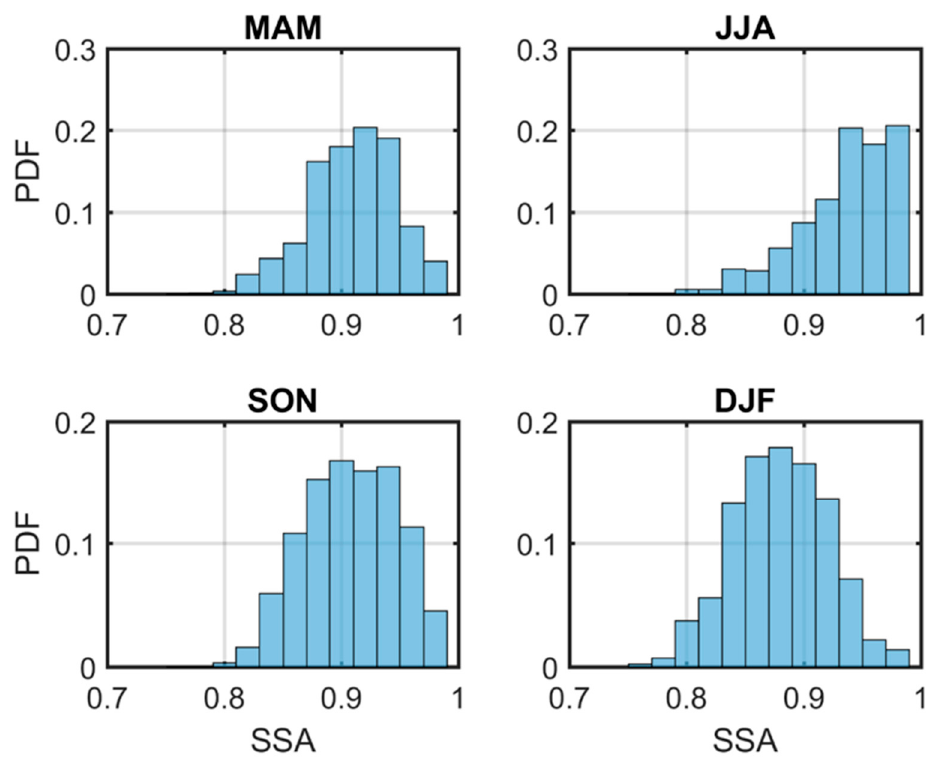
Figure 15. Histograms of the SSA(single scattering albedo) values at the Beijing-PKU site during 2016–2019. Table 1. Statistics of the retrieved AOD 550 nm against ground measurements using two kinds of aerosol profiles.